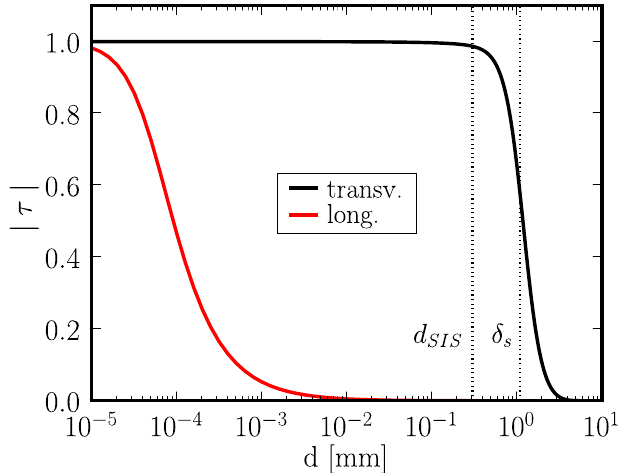
FIG. 4. (Color) Comparison of transverse and longitudinal trans- mission coefficients for SIS 18 parameters vs wall thickness. The . The SIS 18 wall thickness and frequency is chosen as f (cid:2) f 0 the skin depth are